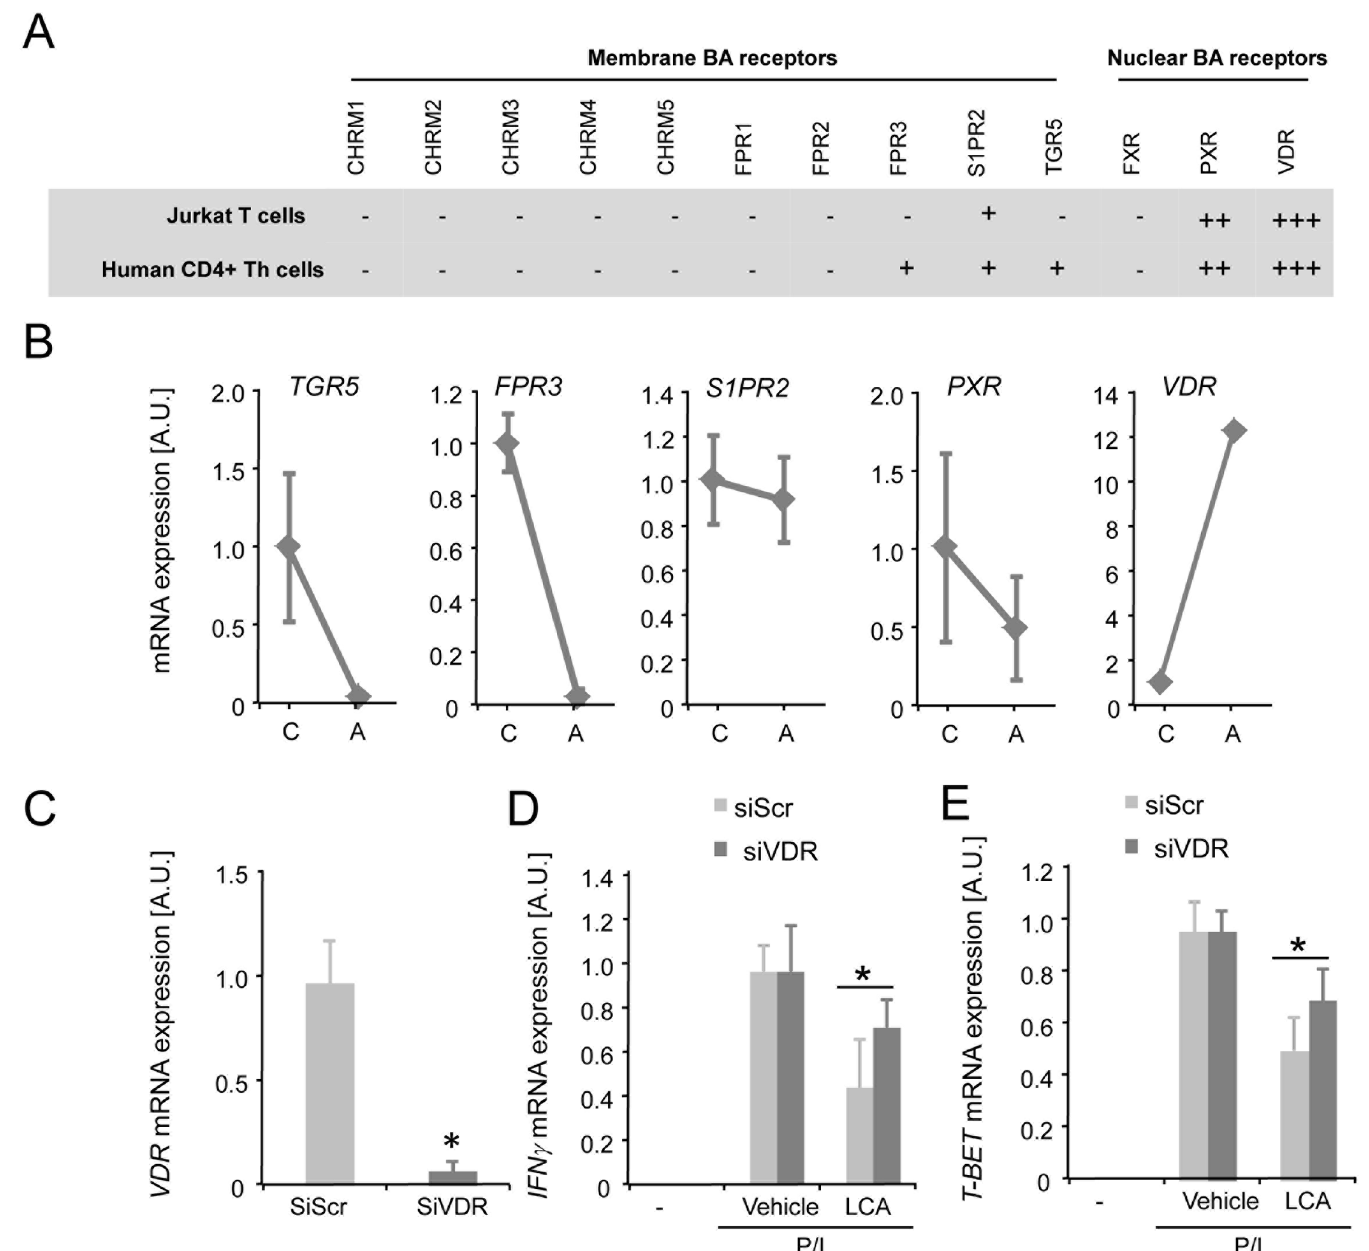
Fig 5. Characterizing the LCA sensor in CD4 + Th cells. (A) Table showingmRNA expressionof Membraneand Nuclearbile acid receptors in Jurkat T cells and primary human CD4 + Th cells. “+” indicatesthat the gene is expressedat low levels, i.e. Real-timeRT-PCR Ct cycles of 30–35; “++” indicatesthat the gene is expressedat Ct cycles of 25–30, and “+++” indicates highexpressionof the gene at Ct cycles of < 25. (B) mRNA expressionof TGR5 , FPR3 , S1PR2 PXR and VDR in resting “C” and in DynabeadsT-activator stimulatedprimary humanCD4 + Th cells “A”. (C) mRNA expressionof VDR in Jurkat T cells transfected with silencingRNA against the VDR (siVDR; light grey bar) or scrambledsiRNA (siSCR; dark grey bar). (D) IFN γ and (E) T-BET mRNA expression in Jurkat T cells transfected with siRNA againstthe VDR (siVDR; light grey bars) or scrambledsiRNA (siScr; dark grey bars) in responseto P/I stimulation and in combination with 10 μ M LCA or vehicletreatment. LCA, lithocholicacid; P/I, PMA/ionomycin; AU, Arbitrary units. Results represent the mean ± SEM. NS, Not significant. * Statistically significant,P < 0.05.Experiments were performed in triplicatesand repeatedat least twice.